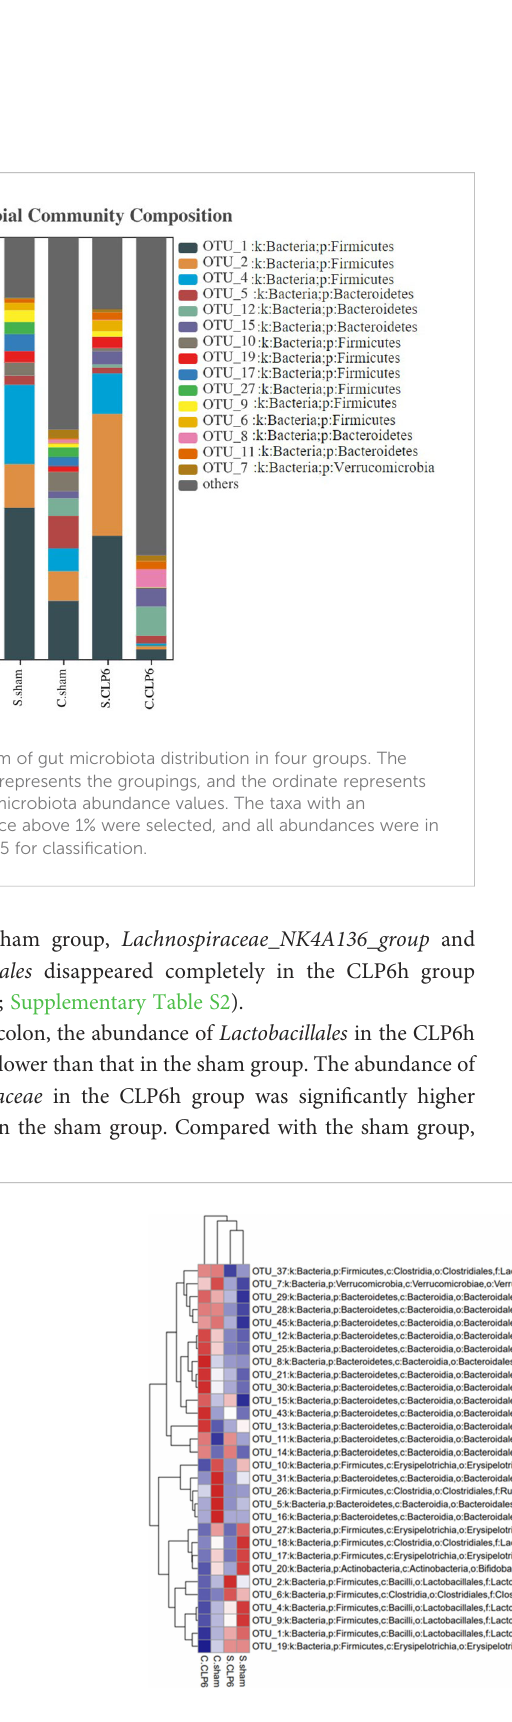
FIGURE 3 The dominant gut microbiotas in the different intestinal segments of mice in the sham group and the CLP6h group were characterized by their abundances in a heatmap. Abundance is represented by color depth. The redder the color of the square, the higher the abundance of the strain among the samples.